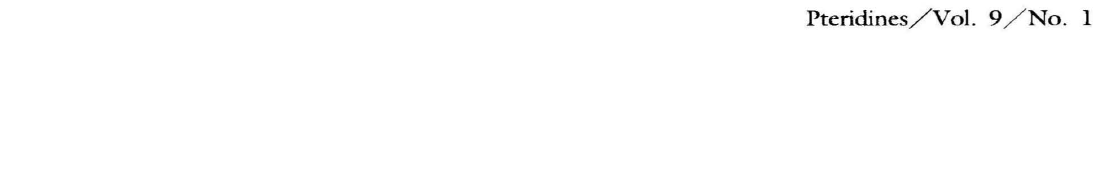
Figure 1. Elution profile of sepiapterin deaminase from a Mono Q column. Proteins were eluted with a linear gradient to 0-0.7 M NaCl in PPB at a flow rate of 1 ml/ min and monitored absorbance at 280 nm (- ). The la teral stripes area, fractions 18 and 19, indicates the frac tion containing the enzyme